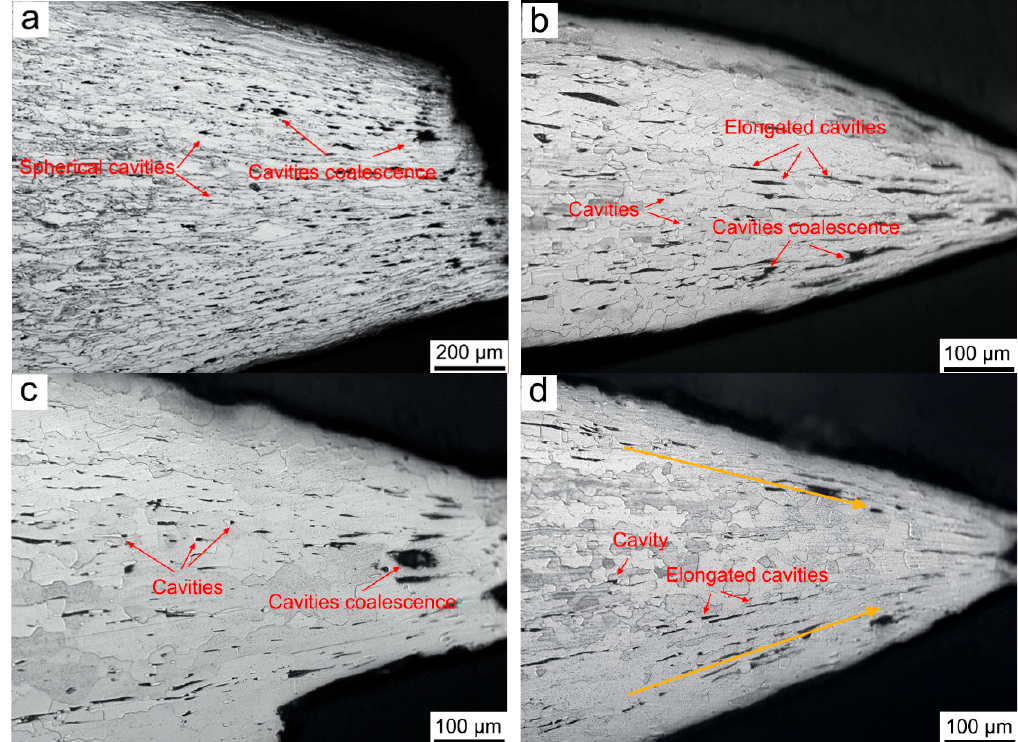
Figure 5. Cross-sectional microstructures of the fracture tips of the specimens after tensile tests at different conditions: ( a ) 873 K and 1.7 × 10 − 4 s − 1 ; ( b ) 1023 K and 1.7 × 10 − 4 s − 1 ; ( c ) 1123 K and 1.7 × 10 − 4 s − 1 ; ( d ) 1123 K and 1.7 × 10 − 2 s − 1 .